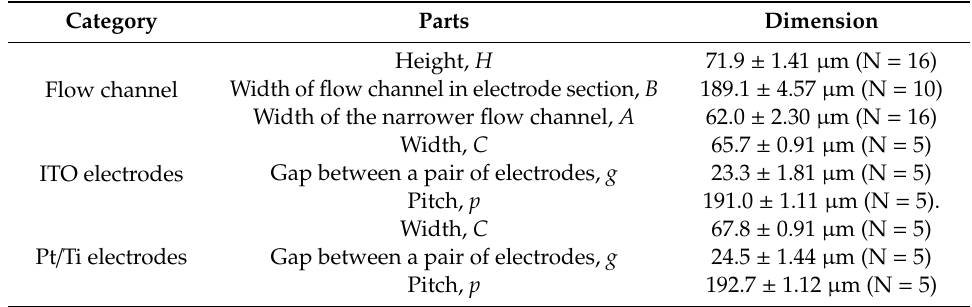
Table 1. Dimensions of the micro-nozzles integrated with indium tin oxide (ITO) micropumps and electrodes.